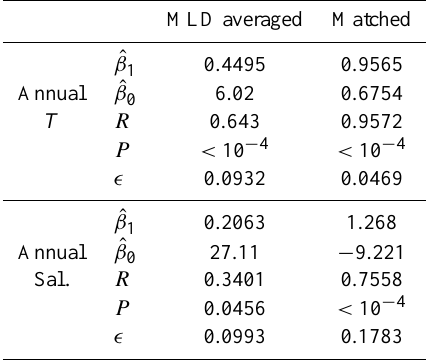
Fig. 17. North Sea mean summer chlorophyll time series: the black line is the matched model mean summer chlorophyll, the dashed line the mean summer in situ chlorophyll, and the grey area shows the MLD-averaged mean chlorophyll of the North Sea. Table 6. Linear regression output parameters for temperature ( T ) and salinity (Sal.). The parameters shown are the slope of the line ( ˆ β 1 ), the y-axis intersect ( ˆ β 0 ), the correlation coefficient ( R ), and the two-tailed probability ( P ), the standard error ( (cid:15) ), and the num- ber of data ( N ). MLD